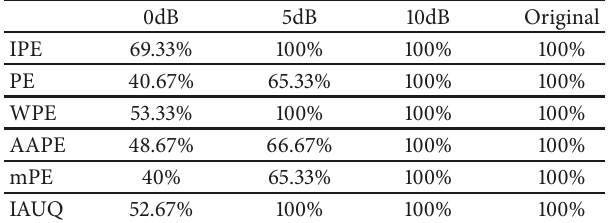
Table 3: Classification accuracy of three types of ships by